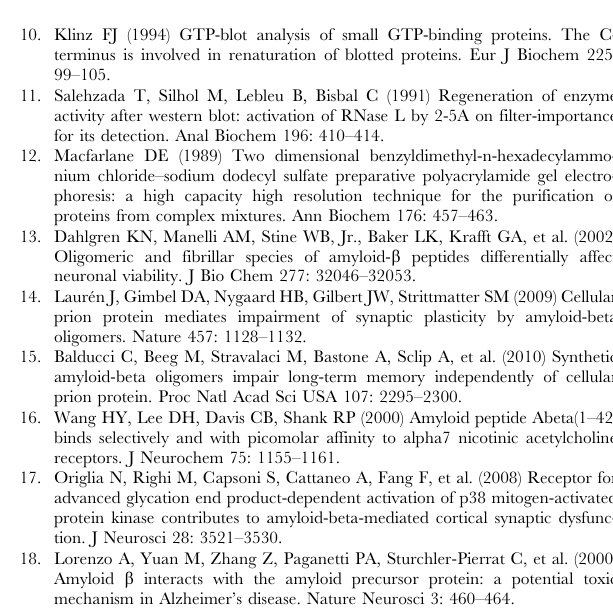
Table S1 Diffusion coefficients of disaggregated A b 1–40 peptide in solution as determined by STD-NMR. Expected (as standard curves) and obtained diffusion (m 2 /sec) for A b 1–40 peptide at different temperatures (5, 25 or 37 u C). Nuclear magnetic resonance (NMR) experiments were performed using a Varian 400-MHz Mercury (Varian, Palo Alto, CA) equipped with a z -axis gradient coil. Pulse field gradient NMR diffusion measurements give molecular size through the measurement of diffusion coefficients. 1 H spectra were acquired with 128, 160, 256 or 512 transients and 2 s recycle delay. Diffusion experiments were performed employing an array of 20 or 30 spectra for each experiment (128, 256 or 512 transients each, with a 1 or 2 s recycle delay) varying the gradient strength from 3.33 to 19.4 G/cm 2 . The lengths of and delays between the gradient pulses were optimized depending on the experimental conditions and ranged between 0.002 and 0.005 s and 0.2–0.7 s, respectively. Data were fitted and diffusion coefficients determined with the Dosytoolbox software.